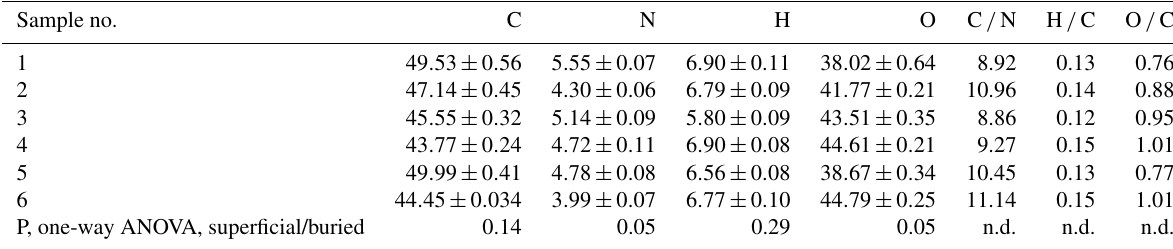
Table 2. Elemental composition (%) and atomic ratios in HAs. Data presented in atomic values. Sample